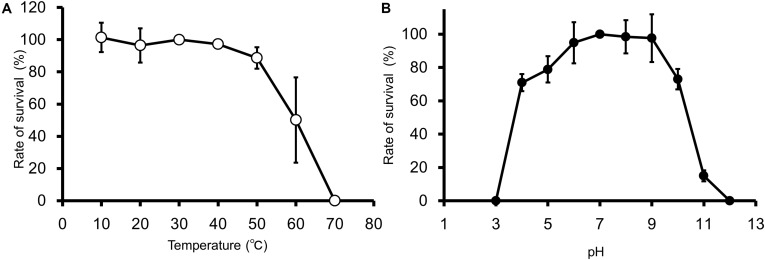
Thermal and pH stability of EspM4VN. Course of survival ratio (%) of EspM4VN particles during heat (A) and pH (B) treatments is plotted. The mean titer is shown from triplicate assays.